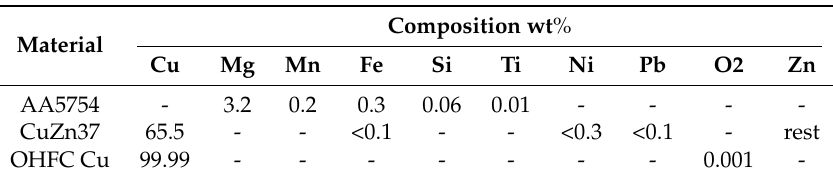
Table 1. The chemical composition of Al, Cu and Br.